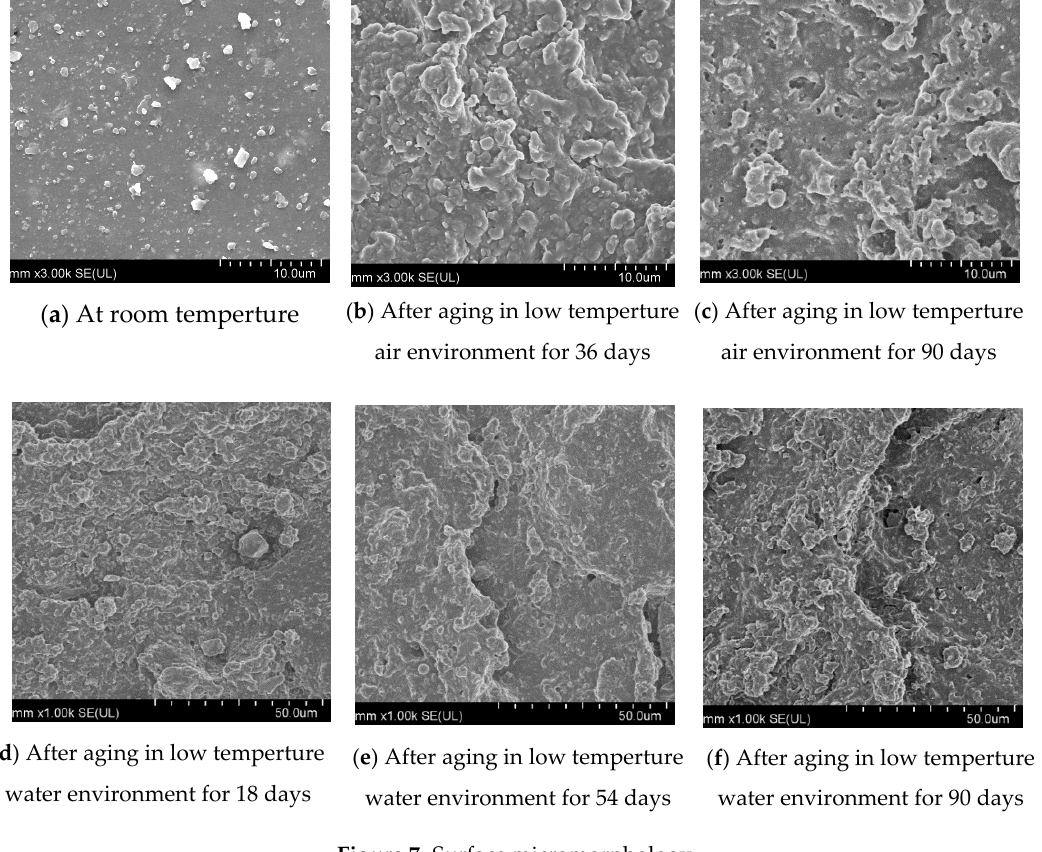
Figure 7. Surface micromorphology.